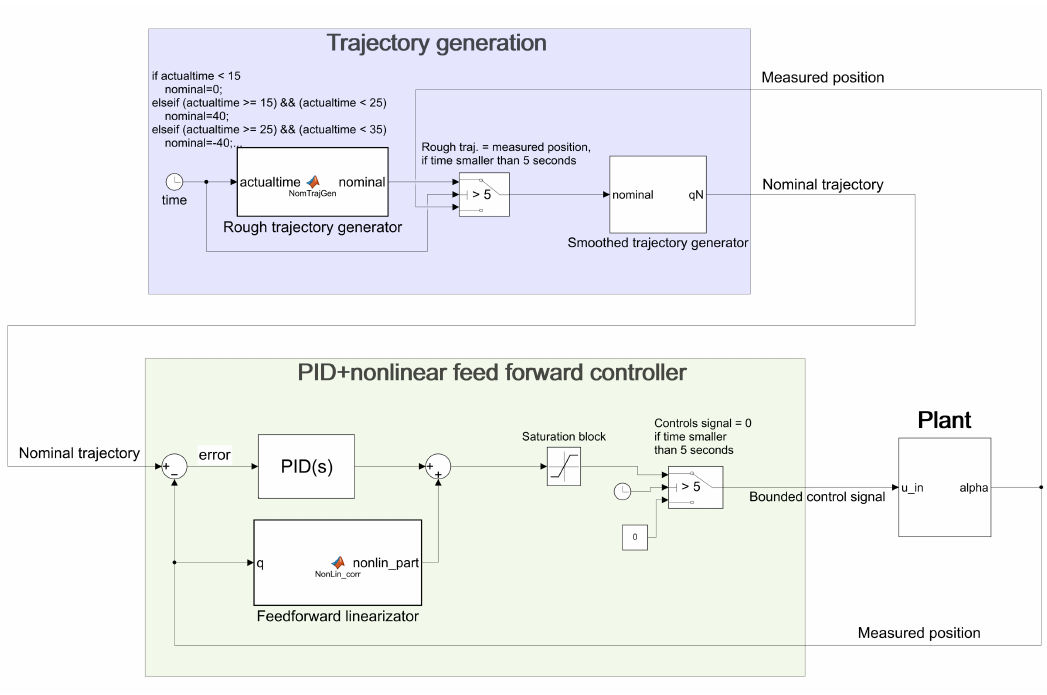
Figure 14. Details of the “PID with nonlinear feedforward” control scheme modeled in Matlab Simulink.